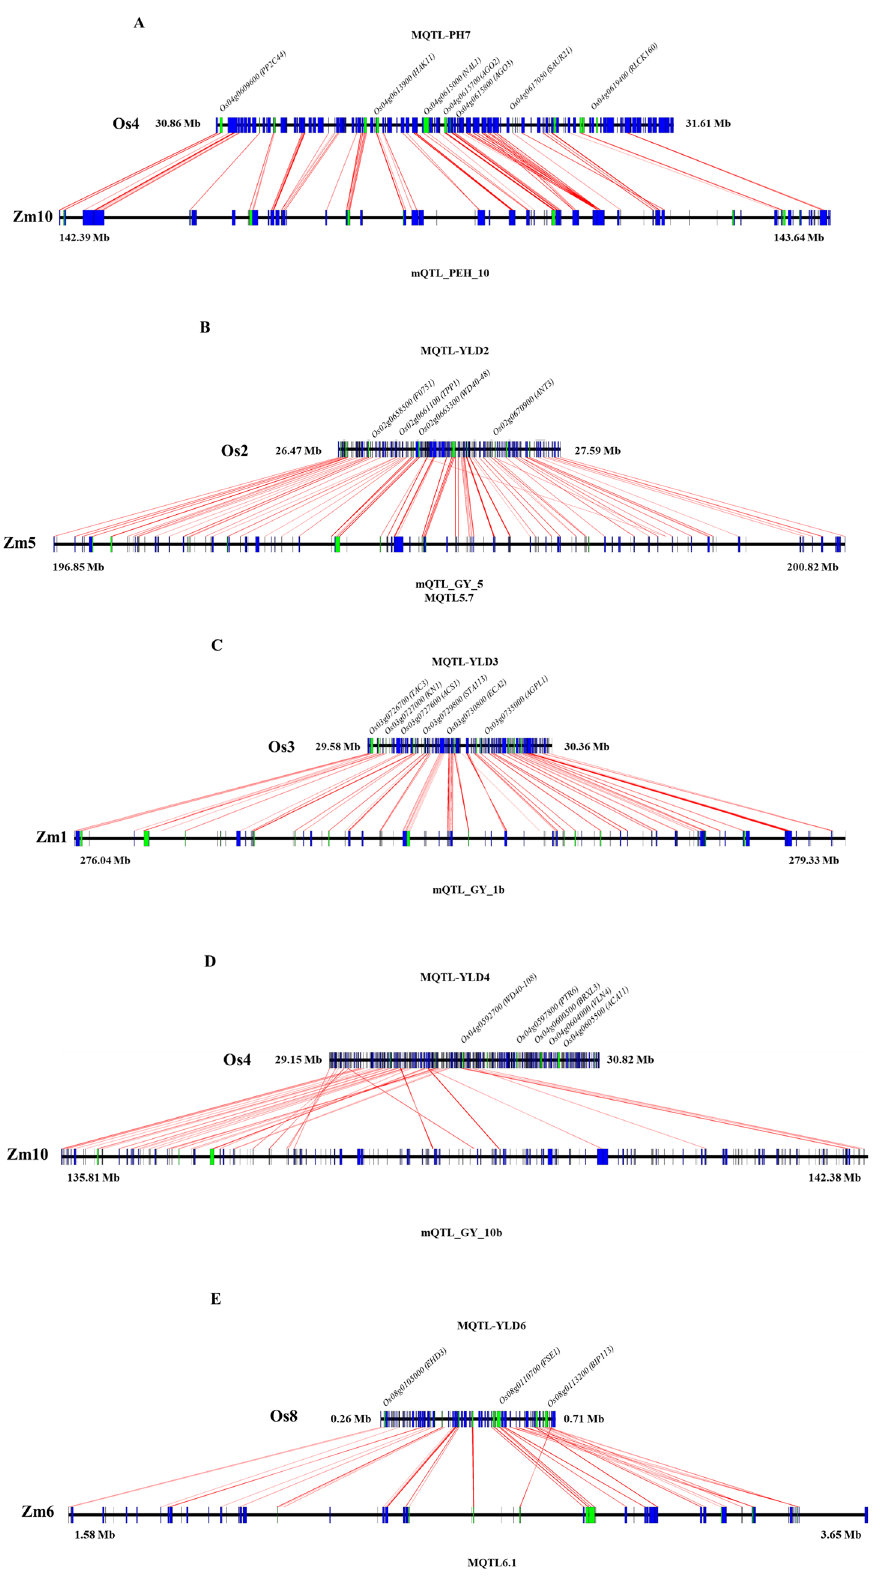
Figure 4. Comparative maps of ortho-MQTLs between rice and maize. ( A ) ortho-MQTL-PH7, ( B ) ortho-MQTL-YLD2, ( C ) ortho-MQTL-YLD3, ( D ) ortho-MQTL-YLD4 and ( E ) ortho-MQTL-YLD6. The chromosome number, genomic position in Mb and the original name of MQTLs are indicated. The orthologous genes in rice and maize are indicated in green color with the corresponding rice gene